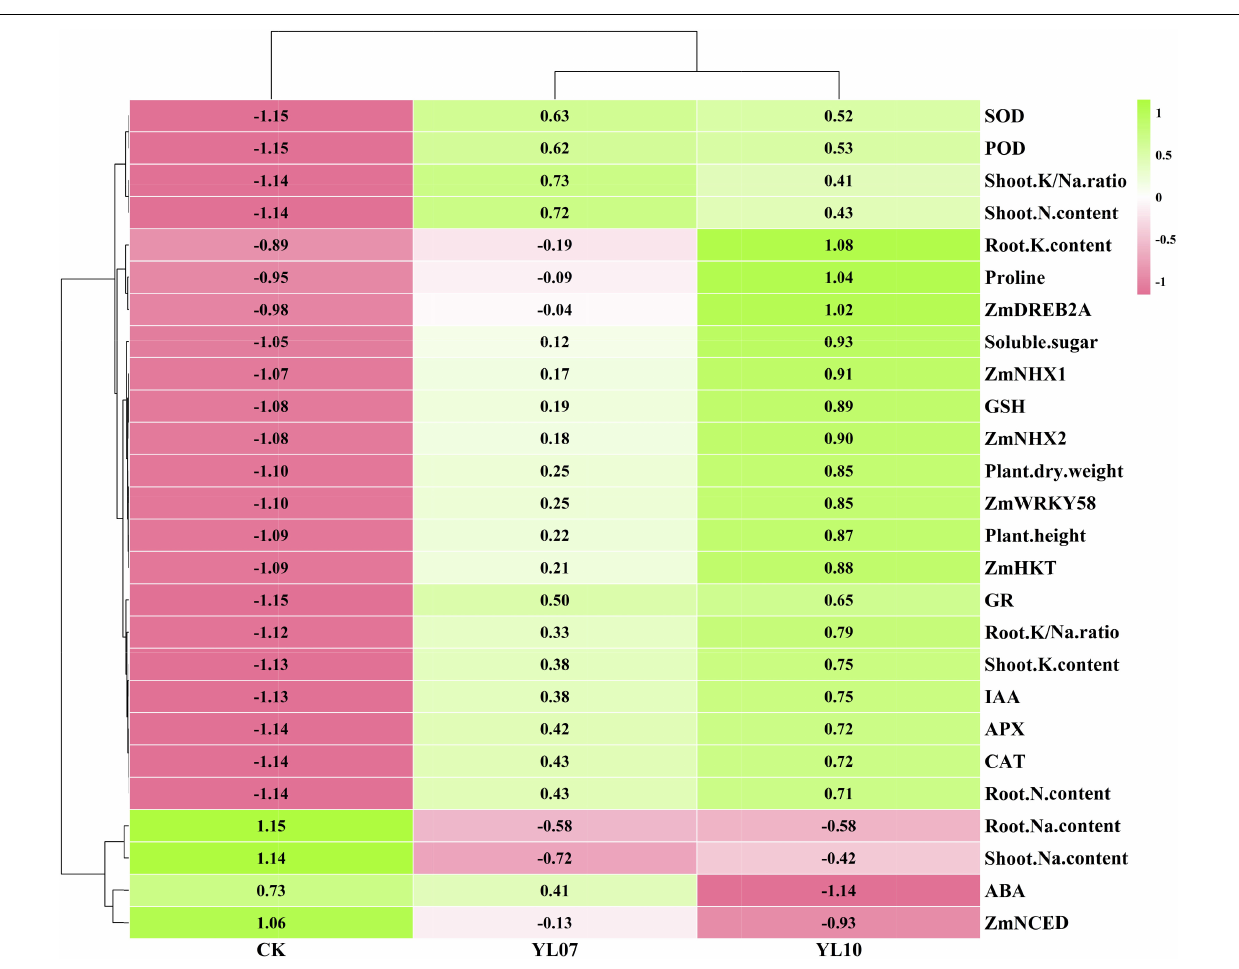
FIGURE 5 | Hierarchical clustering to understand treatment-variable relationships in maize plants under NaCl stress